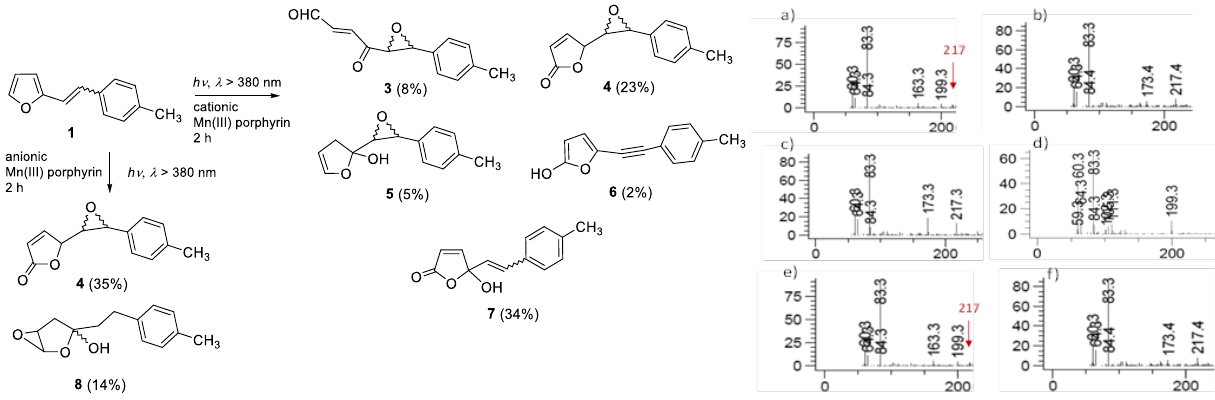
Scheme 1. Reaction pathway and product ratios for the photocatalytic oxygenation of 1 in air-saturated system at pH 7, using cationic/anionic Mn(III) porphyrins, together with mass spectra obtained in the experiment using cationic Mn(III) porphyrin at the following retention times: 0.908’ ( a ) for 5 , 0.946’ ( b ) for 4 , 1.012’ ( c ) for 3 , 1.175’ ( d ) for 6, and 1.278’ ( f ) for 7 ; and using anionic Mn(III) porphyrin at 0.824’ ( e ) for 8 .